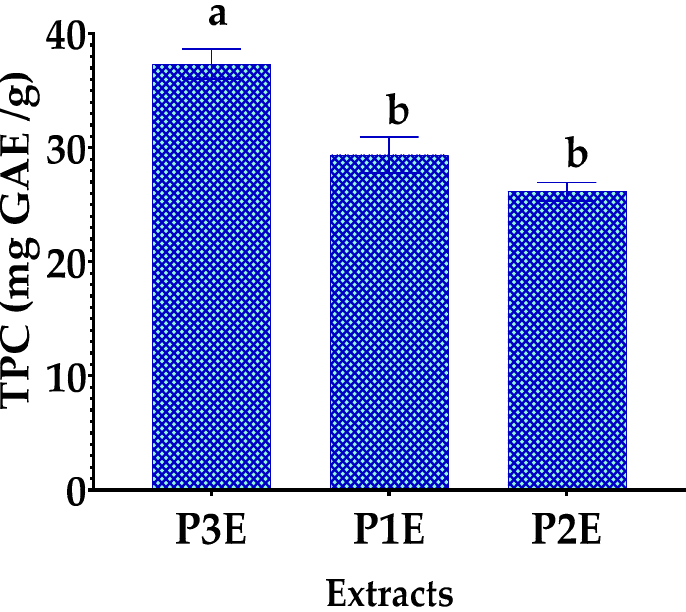
Figure 1. Polyphenol content in the P1E, PE2, and PE3; GAE: gallic acid equivalents; a and b—values with a significant difference ( p < 0.05).